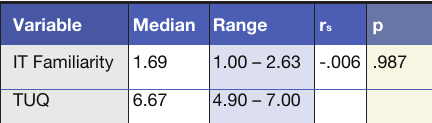
Table 3: Spearman’s correlation coefficient analysis of IT Familiarity and TUQ